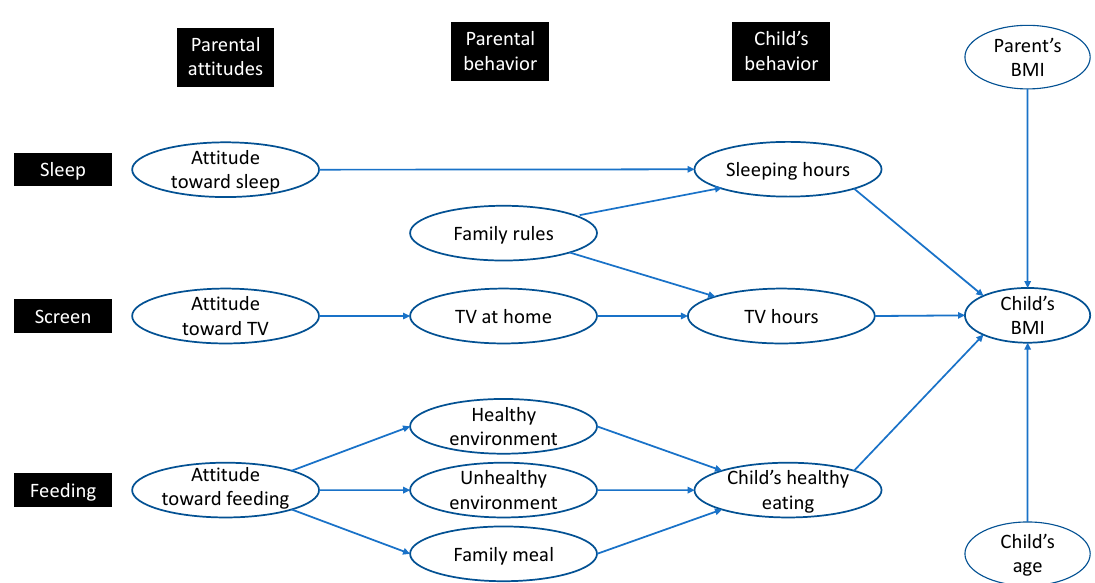
Figure 1. Proposed framework: from parental attitudes to a child’s body mass index.